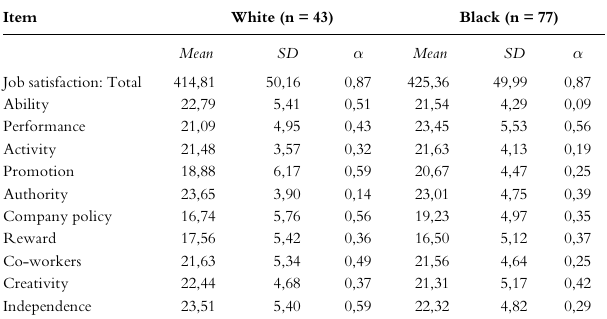
FORDIFFERENT RACEGROUPS